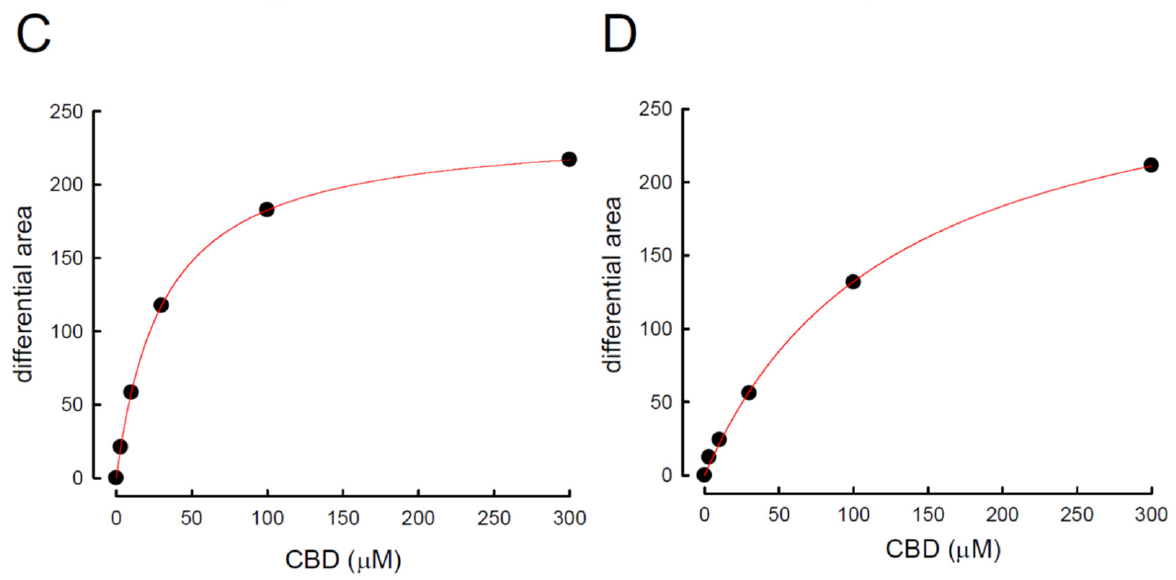
Figure 5. Recovery course from slow-inactivation and affinity of cannabidiol to the slow-inactivated Na v 1.4 channel. ( A ) Patched cells expressing the Na v 1.4 channel were held at − 120 mV for 5 s. An inactivating pulse at − 10 mV for 18 s was applied with a subsequent repolarization to − 120 mV for a certain time to eliminate the channels with fast inactivation. The second test pulse of 0 mV was applied after an intervening gap at − 120 mV for different lengths of time (0.003, 0.006, 0.009, 0.012, 0.015, 0.018, 0.021, 0.024, 0.027, 0.11, 0.12, 0.31, 0.51, 1, 2, 3, 4, and 5 s). Representative currents were overlaid according to the time sequence of examination. Time scales were applied for current kinetics only. The relative current, defined as the normalized peak current in the second test pulse (to the peak current in the first test pulse), was plotted against the length of intervening gap to obtain the time course of recovery from slow-inactivation in control (n = 5) Na v 1.4 channels and those treated with different concentrations of CBD (n = 5). Note the close-up view of the first 500 ms of data shows a significant dose-dependent change in the recovery of slow-inactivation after CBD treatment (inset figure is a closed-up view of Figure 5A; * p < 0.05). ( B ) Approaches and analysis protocols were the same as in Figure 5A, except that the inactivating pulse was set at − 80 mV for 18 s. ( C ) Difference between the area in control and upon different concentrations of CBD in Figure 5A to the maximal difference giving the relative difference in the area, which is plotted against the CBD concentration (see Supplementary Data Figure S1). The line is the fit of data points using the following formula: relative difference in area = ([CBD]/31.5)/(1 + [CBD]/31.5), where [CBD] denotes CBD concentration in µ M [41]. ( D ) Analysis protocols were the same as those of Figure 5B, except that the inactivating pulse was set at − 80 mV for 18 s. The line is the fit using the following formula: relative difference in the area = ([CBD]/127.3)/(1 + [CBD]/127.3), where [CBD] denotes CBD concentration in µ M